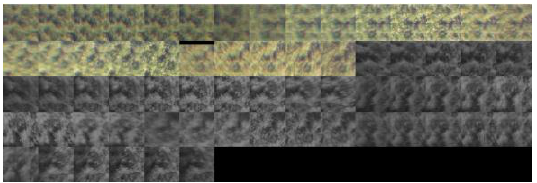
Figure 2: Feature track that corresponds to a single 3D point. Show are the image patches for which the keypoints could be automatically matched and veryfied by their geometric consistency of the overall reconstruction. One can see image patches from the images in the visible specturm and NIR image